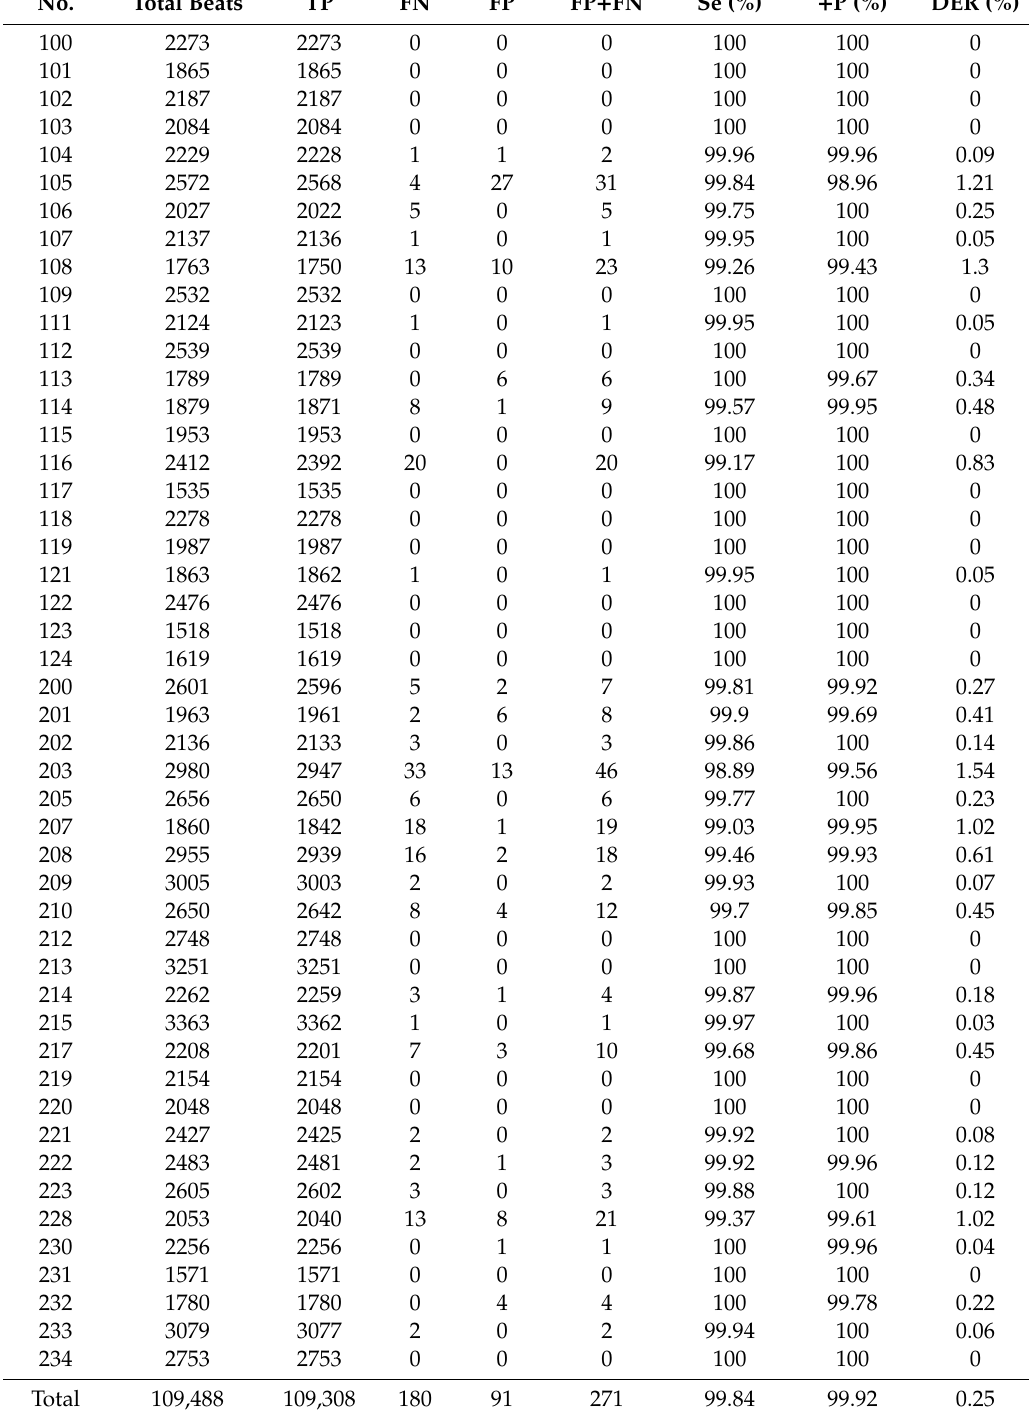
Table 1. Summary performance of the proposed QRS peak detection system using the first channel of the MIT-BIH arrhythmia